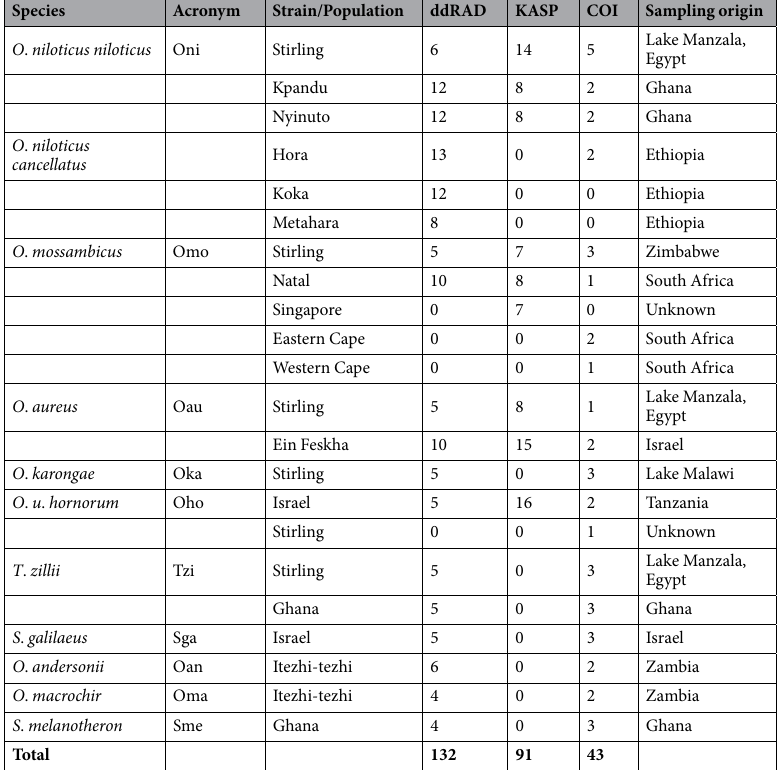
Table 1. Origin of tilapia samples used in ddRAD analysis, SNP validation by KASP and COI sequencing. A total of 34 samples (10 O . niloticus , 6 O . mossambicus , 13 O . aureus and 5 O . u . hornorum ) were analysed using both ddRADseq and KASP. The 43 samples analysed by COI sequencing comprised representatives from each of the ten-fish species (of which 29 samples were also characterised by